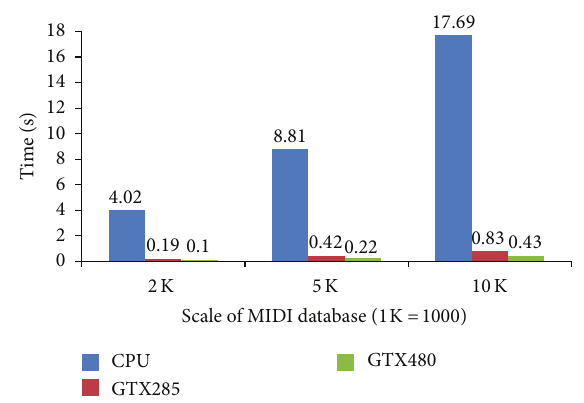
Figure 2: Comparison of execution times with different scale of MIDI database.